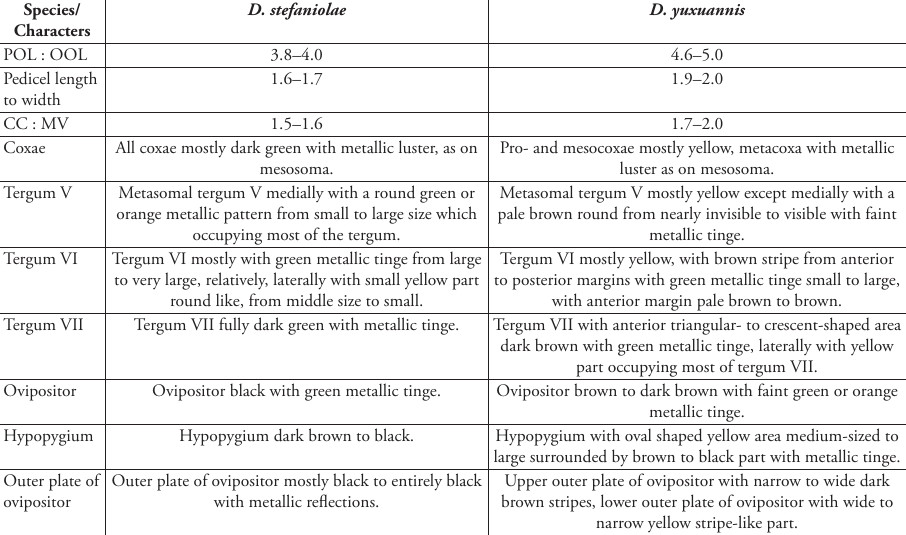
Table 1. Summary of morphological differences between Dzhanokmenia stefaniolae and D. yuxuannis